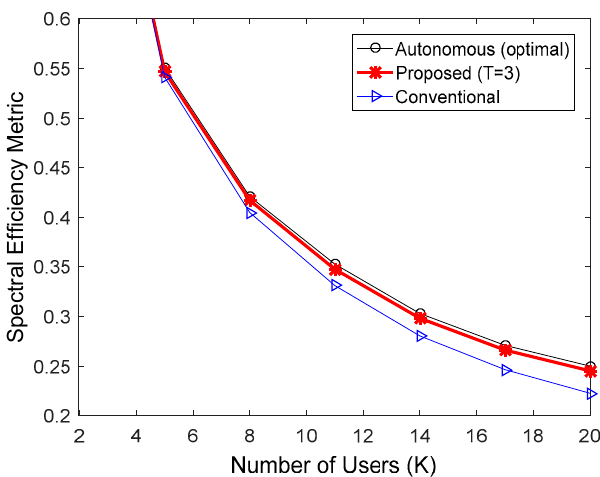
Figure 9. Comparison of spectral efficiency in the IEEE 802.16e downlink when MCS levels were dynamically changed over 4–11.